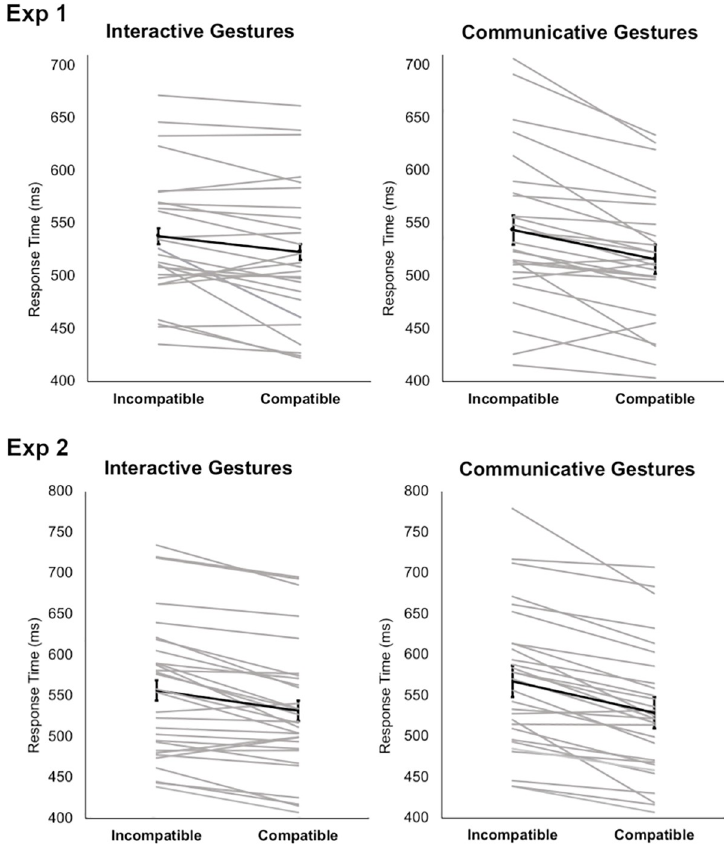
indicate single-subject values and black thick lines indicate the group means and standard